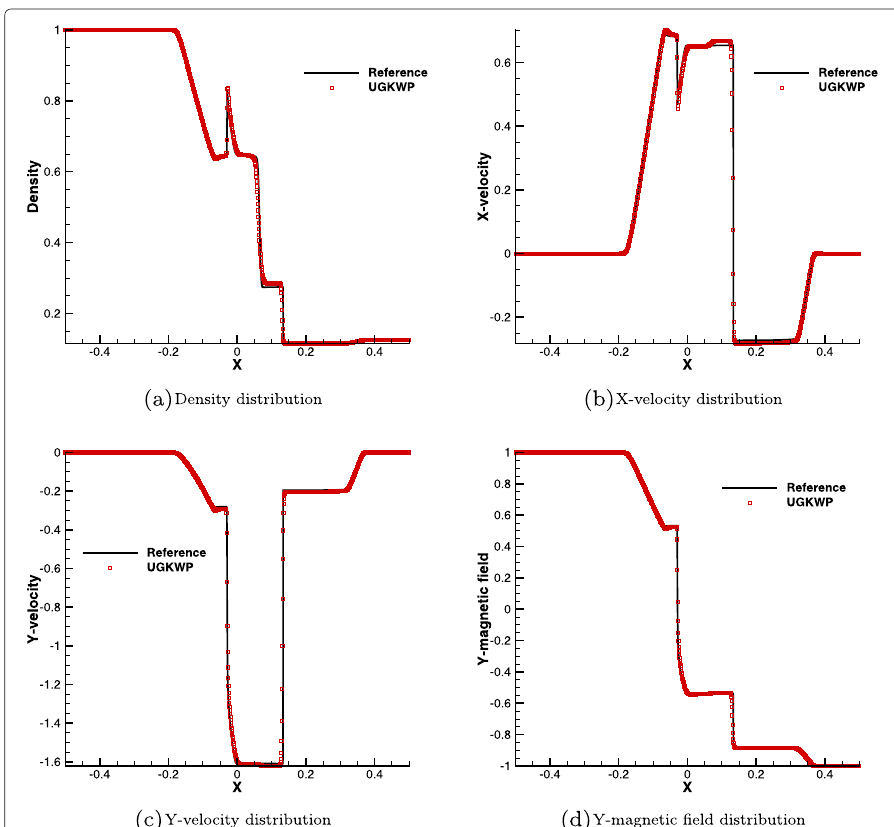
Fig. 11 Multiscale Brio-Wu shock tube problem with Kn=10 4 and r 0. Lines show the UGKWP solutions and symbols show the reference MHD